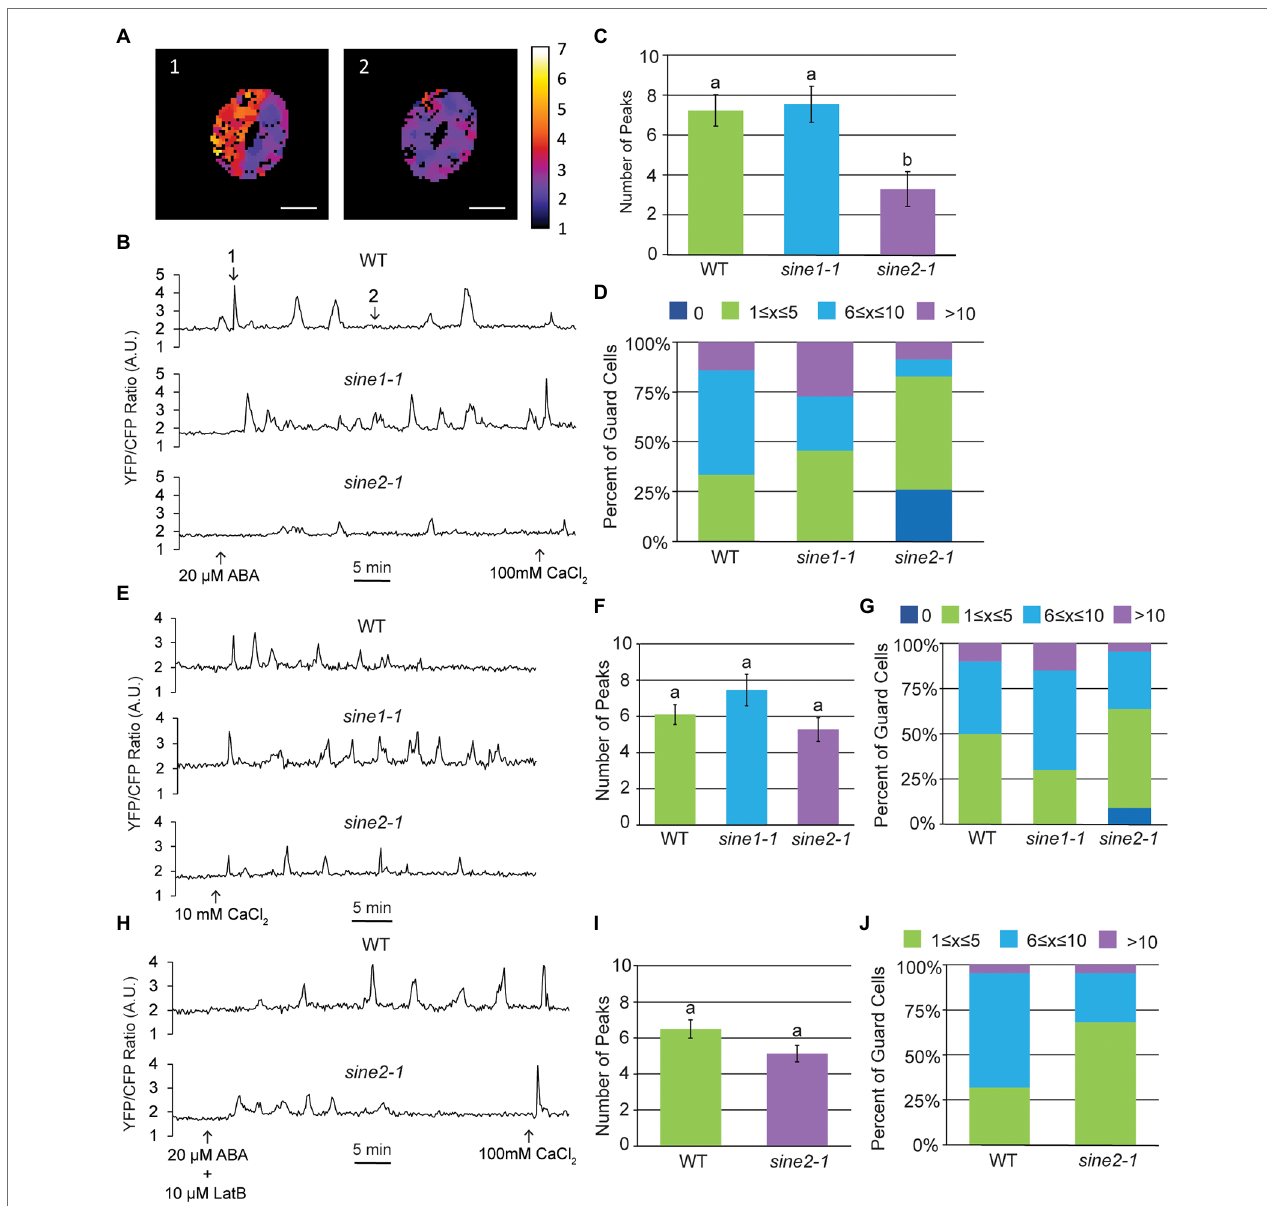
FIGURE 4 | Cytoplasmic calcium oscillation is disrupted in sine2-1 . (A) Ratiometric images of cytoplasmic Ca 2+ in WT after addition of 20 μ M ABA. Images shown are of the guard cell cortex at two individual time points. Scale bars = 10 μ m. (B) Characteristic WT, sine1-1 , and sine2-1 Ca 2+ oscillations in response to 20 μ M ABA, presented as FRET ratio of YFP to CFP fluorescence intensity. Numbers in the WT graph correspond to the image numbers in (A) . (C) Number of peaks observed after addition of ABA in WT, sine1-1 , and sine2-1 guard cells. Statistical significance was calculated using one-way ANOVA followed by a post-hoc Tukey HSD test. Lowercase letters denote groups that are statistically different ( p < 0.01). (D) Number of peaks observed were grouped into several categories for WT, sine1-1 , and sine2-1 . (E) Representative Ca 2+ oscillations in WT, sine1-1 , and sine2-1 in response to exogenous 10 mM CaCl 2 . (F) Number of peaks observed after addition of ABA in WT, sine1-1 , and sine2-1 guard cells. Statistical significance was calculated using one-way ANOVA followed by a post-hoc Tukey HSD test. Lowercase letters denote groups that are statistically different ( p < 0.01). (G) Number of peaks observed were grouped into several categories for WT, sine1-1 , and sine2-1 . (H) Representative Ca 2+ oscillations in WT and sine2-1 after treatment with 20 μ M ABA +10 μ M LatB. (I) Number of peaks observed after addition of 10 μ M LatB and